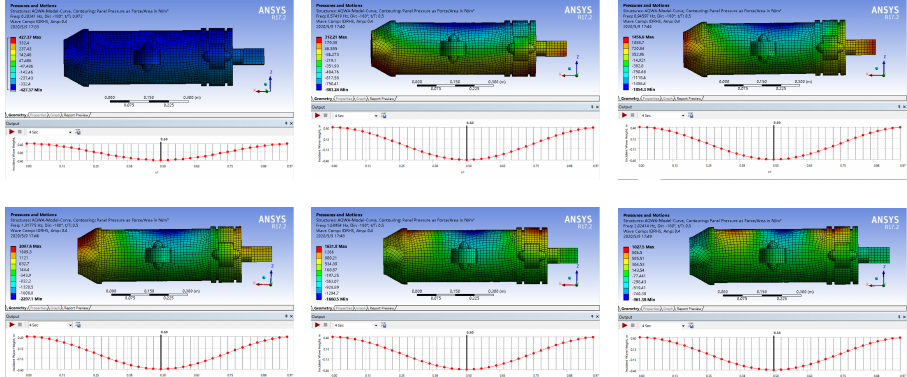
Figure 17. From top to bottom, from left to right: surface pressure nephogram of the Shark-AUV at dif- ferent wave frequencies (f = 0.20241 Hz, 0.57419 Hz, 0.94597 Hz, 1.31775 Hz, 1.58594 Hz, 2.02414 Hz) when the AUV moves in a head wave and is located in the trough with a wave amplitude of 0.4